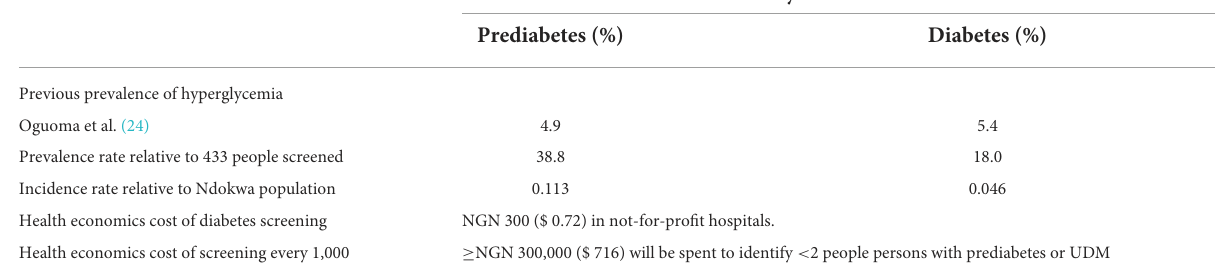
TABLE 1 Simplified cost-effectiveness